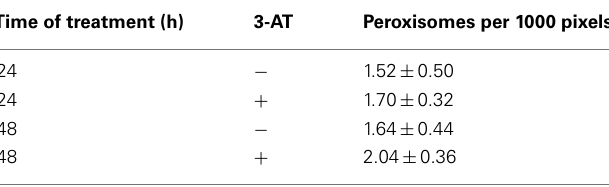
Table 1 | Effects of 3-AT treatment on pmp70-positive peroxisome numbers per unit area of cell.